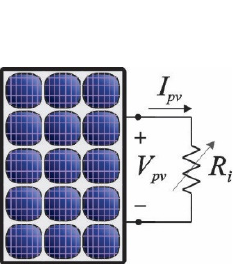
Figure 4. Simplified equivalent circuit of a DC-DC converter feeding a resistive load. Table 3. Input resistance of the main non-isolated DC-DC converters. Figure 3. DC-DC converter applied as MPPT.